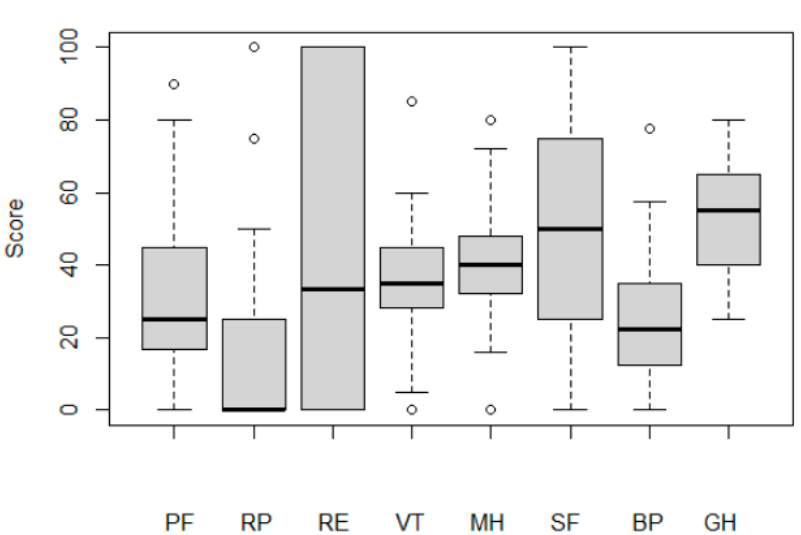
Figure A2. Patients’ quality of life before the TKR, assessed by SF-36 subscales: physical functioning (PF); role limitations due to physical health (RP); role limitations due to emotional problems (RE); energy/fatigue (VT); emotional wellbeing (MH); social functioning (SF); bodily pain (BP); general health (GH).